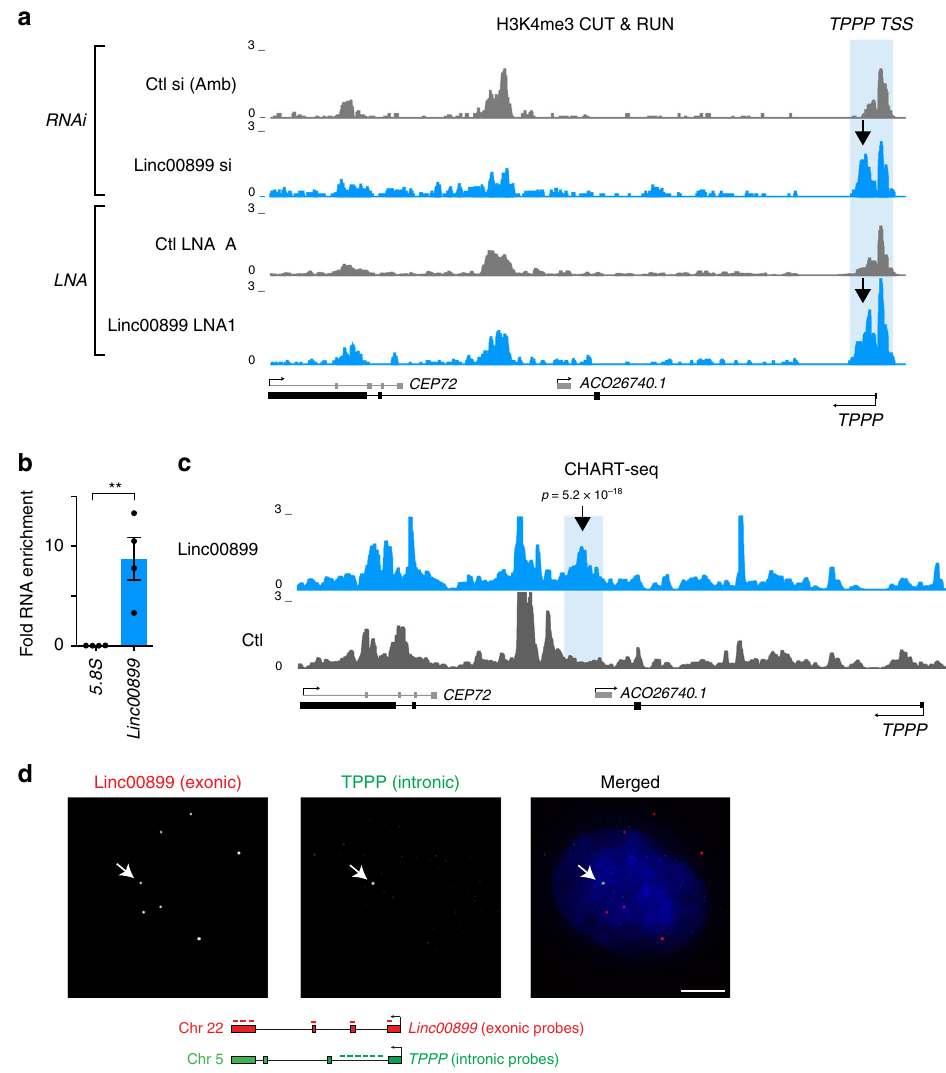
Fig. 9 Linc00899 binds to and represses transcription of TPPP . a CUT&RUN pro fi ling of H3K4me3 enrichment after depletion of linc00899 with RNAi and LNAs at the TPPP locus in HeLa cells. An increase in H3K4me3 (arrow) was observed at the TPPP promoter upon depletion of linc00899 with both LOF methods. Tracks were constructed from averages of two biological replicates for each condition. TSS, transcriptional start site. b Enrichment of linc00899 using a cocktail of four oligonucleotides complementary to accessible regions of linc00899 (as determined by RNase H mapping, Supplementary Fig. 14a), compared to a mixture of two control oligonucleotides containing parts of the linc00899 sense sequence, as measured by qPCR. The 5.8S was used as a negative control region. Data are shown mean ± S.E.M. n = 4 biological replicates. ** P < 0.01 by two-tailed Student t test. c Pro fi ling of linc00899 binding by CHART-seq after RNase H elution at the TPPP locus in HeLa cells. The region with the most signi fi cant increase in linc00899 binding compared to the sense control was present in the second intron of TPPP (arrow). All binding sites were detected using an empirical FDR threshold of 30%. d Validation of linc00899 colocalisation with the TPPP locus by co-RNA FISH in HeLa cells. Linc00899 (exonic probes against the mature transcript) colocalised to the genomic region of TPPP (intronic probes against the premature transcript) in ~3% of the cells ( n = 376). The nucleus was stained with DAPI (blue). Scale bar, 5 μ m. Source data are provided as a Source Data fi